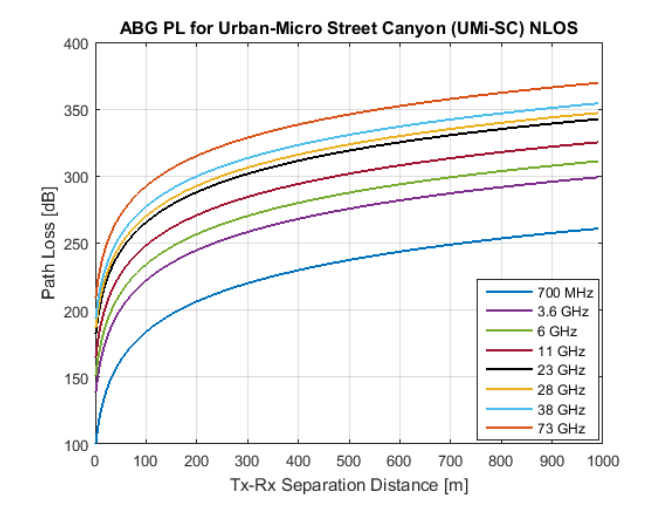
Fig 22. ABG UMi-SC (1000 m) The fig. 23 will show the path loss for ABG UMi open square NLOS condition for a path length of 1000